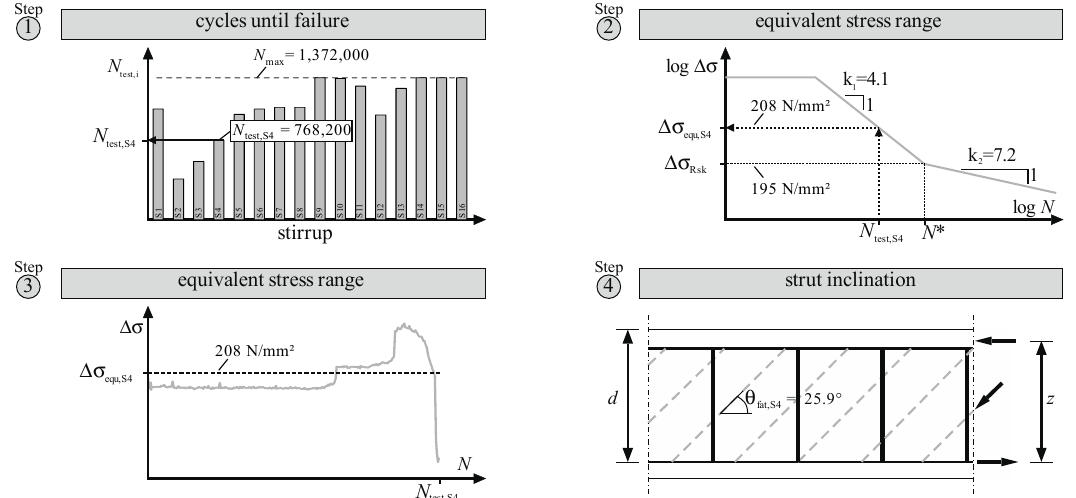
Figure 10. Procedure to determine the strut angle for fatigue according to [46], exemplary for beam T-33-2, stirrup S4.